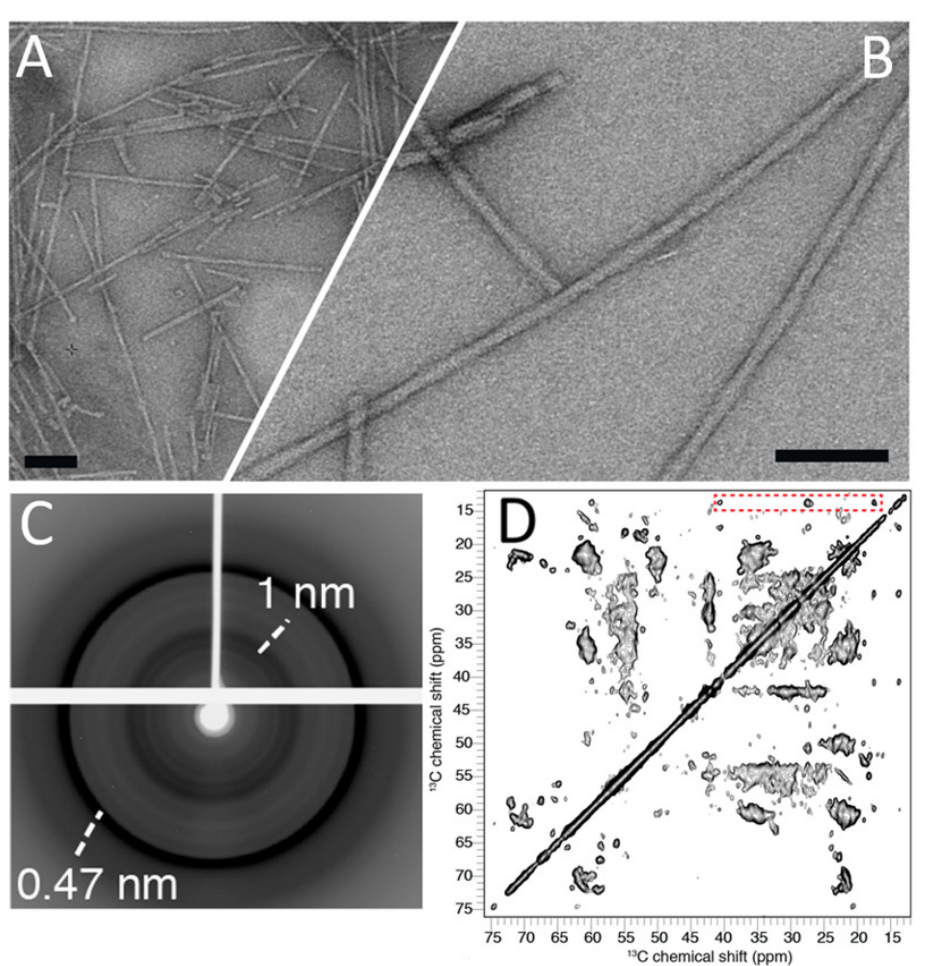
Figure 1. ( A , B ) Transmission Electron Microscopy of 1B fibrils at two magnifications (scale bars: 100 nm); ( C ) X-Ray diffraction pattern of unaligned 1B fibrils, reflections at 4.7 and 10 Å are highlighted; ( D ): two-dimensional MAS NMR 13 C- 13 C correlation experiment probing the residues of the rigid amyloid core of 1B fibrils.